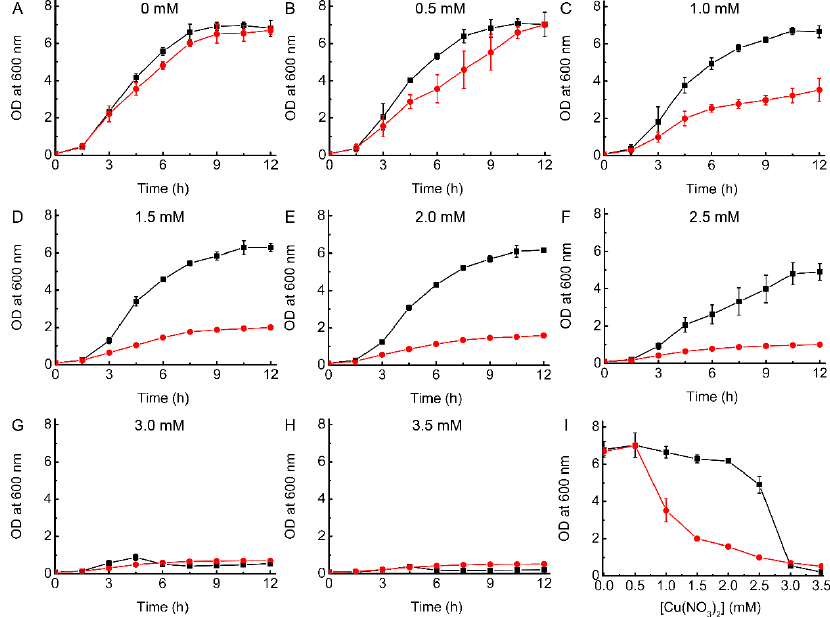
Figure 1. Comparison of Cu resistance in WT and Δ copA E. coli . Growth (37 °C) of WT (black squares) and Δ copA (red circles) E. coli in LB media plus 0 ( A ), 0.5 ( B ), 1.0 ( C ), 1.5 ( D ), 2.0 ( E ), 2.5 ( F ), 3.0 ( G ), and 3.5 ( H ) mM Cu(NO 3 ) 2 . Also shown ( I ) is a comparison of growth after 12 h. The OD values are averages from two ( A ), ( B ) and ( G ), and three ( C ) to ( F ), independent growth experiments (standard deviations are shown), whilst the experiment shown in ( H ) was performed once.